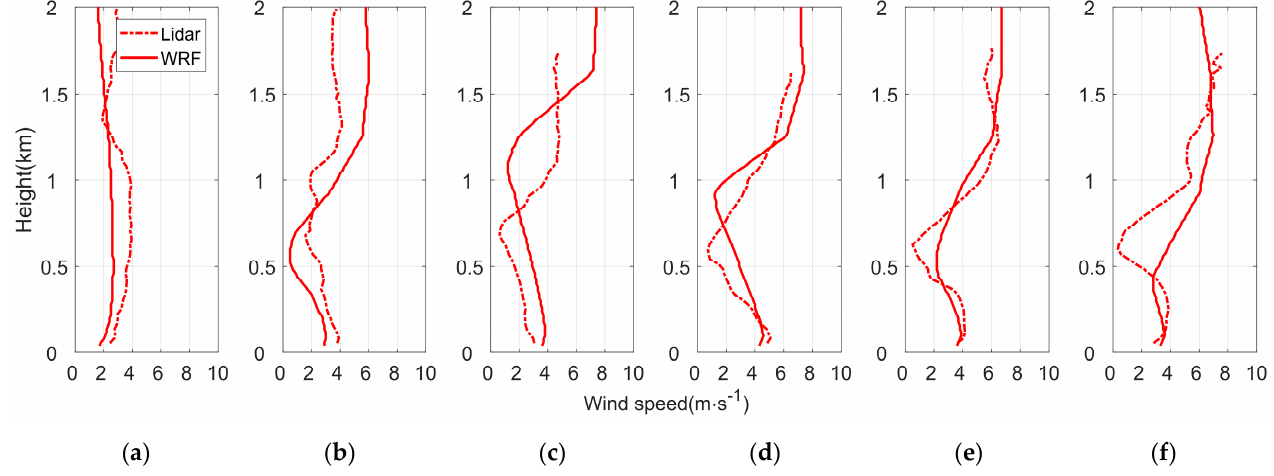
Figure 7. Comparison of lidar measurements and WRF results in horizontal wind speed on 25 September 2019. ( a ) at 17:00 ( b ) at 18:00 ( c ) at 19:00 ( d ) at 20:00 ( e ) at 21:00 ( f ) at 22:00.